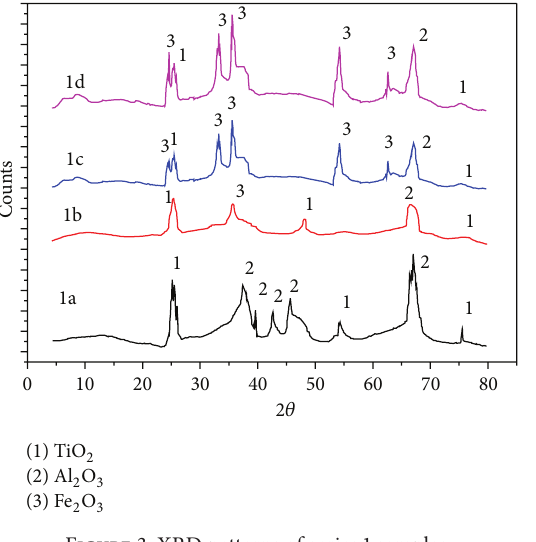
Figure 3: XRD patterns of series 1 samples. Table 5: Effect of TiO 2 .